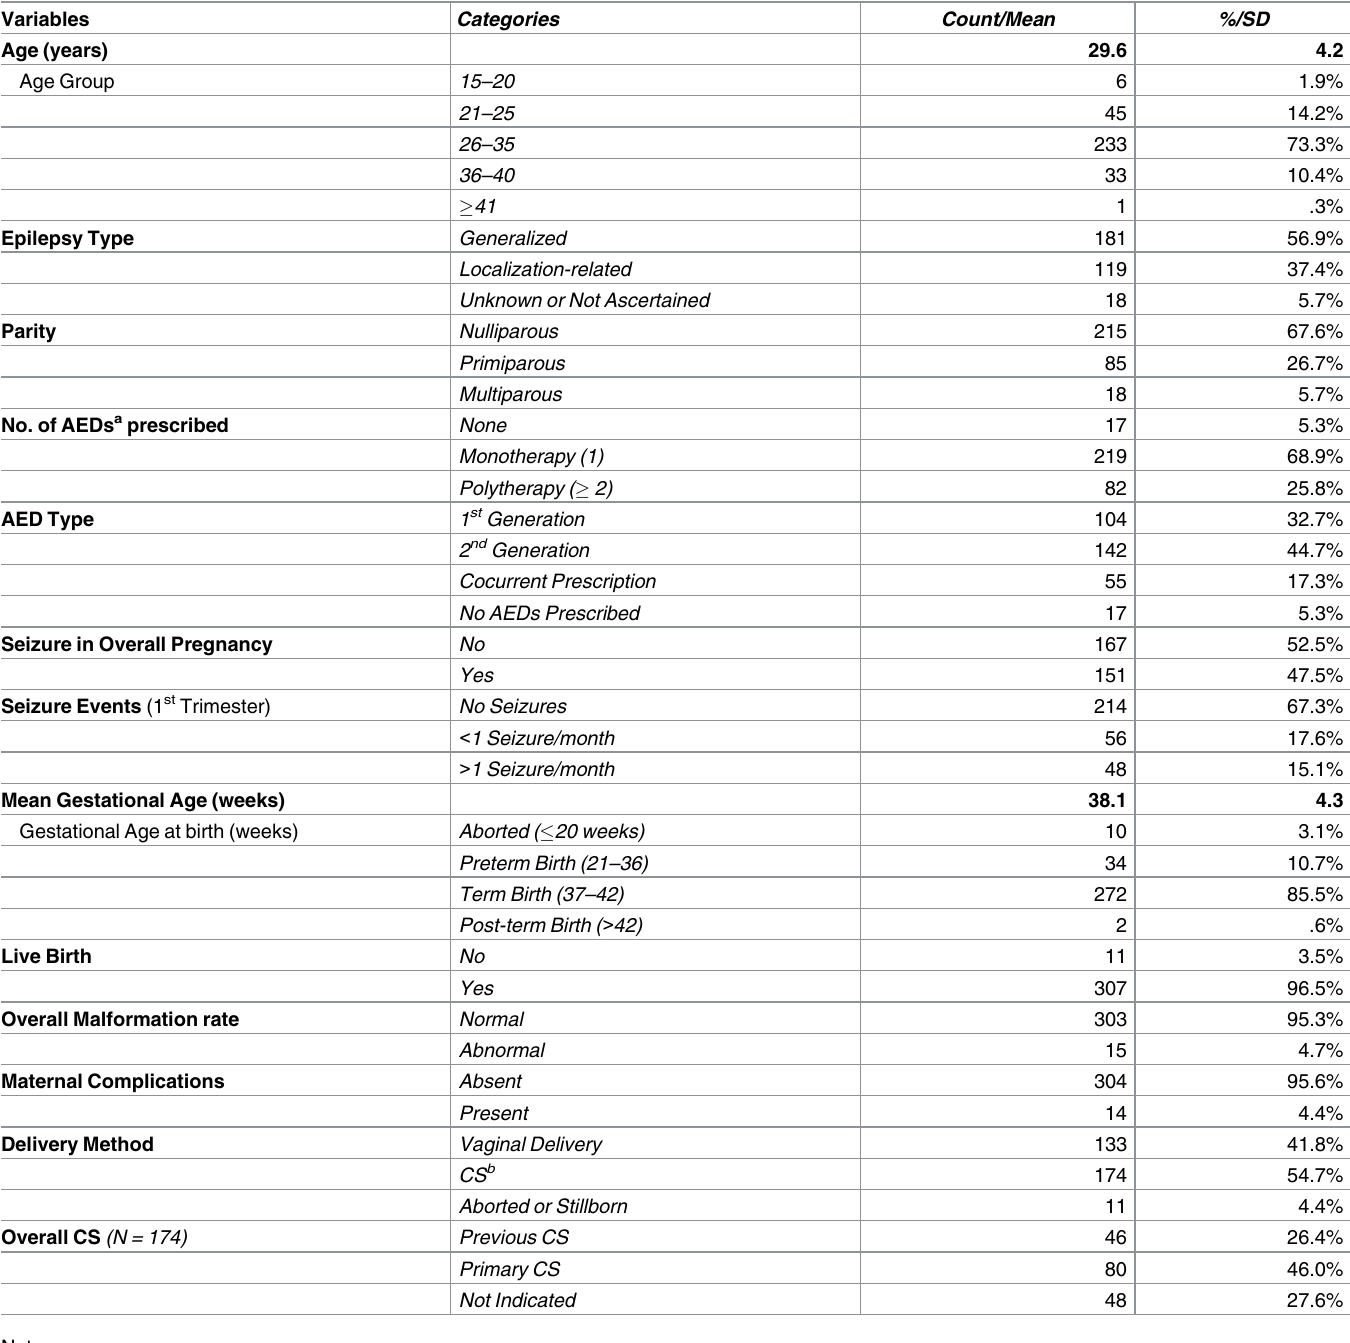
Table 1. Descriptivesof TREP WWE pregnancies (N = 318 c